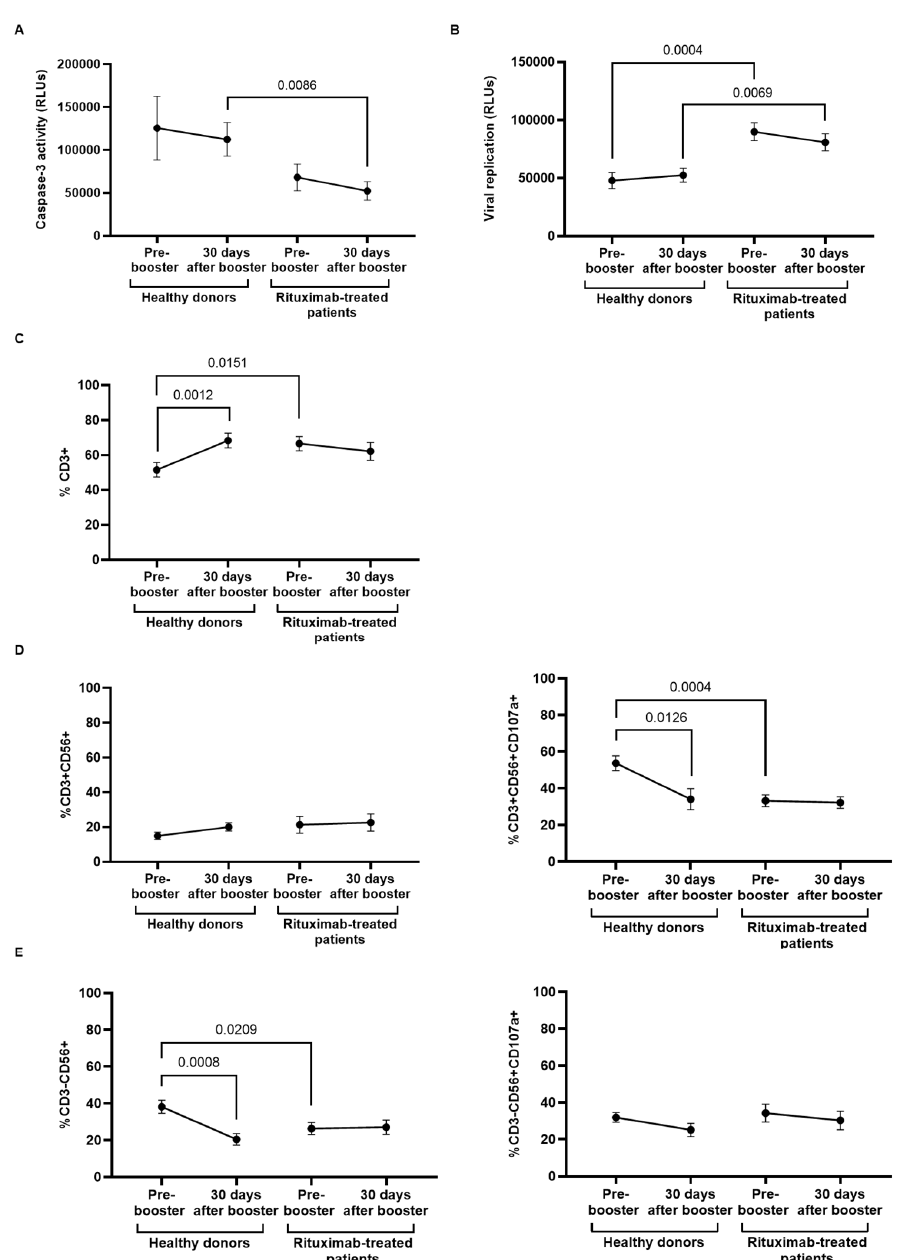
Figure 4. Analysis of DCC response of PBMCs from rituximab-treated patients and healthy donors before and after receiving the booster dose of COVID-19 vaccine. ( A ) DCC was assessed by measuring the activity of caspase-3 in pseudotyped-SARS-CoV-2-infected Vero E6 cells cocultured with PBMCs from rituximab-treated patients in comparison with healthy donors before and after the booster dose. ( B ) The capacity of PBMCs from both cohorts to eliminate pseudotyped SARS-CoV-2-infected Vero E6 cells was determined by quantifying the production of renilla (relative light units, RLUs) after coculture for 1 h. ( C ) Total levels of CD3+ T cells in individuals of both cohorts that were present in the supernatant of the coculture. ( D ) Total levels of NKT-like cells (CD3+CD56+) (left graph) and NKT-like cells expressing the degranulation marker CD107a (CD3+CD56+CD107a+) (right graph) in PBMCs from individuals of both cohorts. ( E ) Total levels of NK cells (CD3−CD56+) (left graph) and NKT-like cells expressing the degranulation marker CD107a (CD3−CD56+CD107a+) (right graph) in PBMCs from individuals of both cohorts. Each dot in the graphs corresponds to the mean ± SEM. Statistical significance between groups was calculated using the Mann–Whitney test, and statistical significance within groups was calculated using the Wilcoxon signed-rank test.